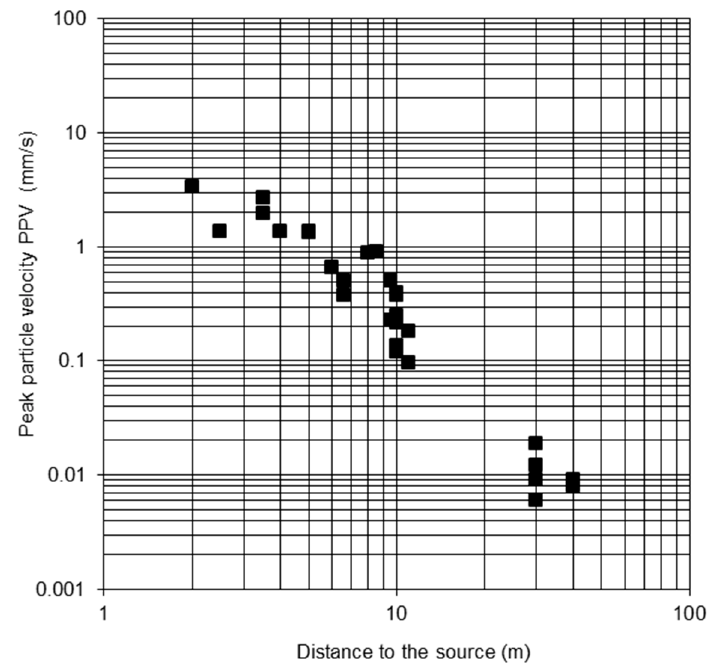
Figure 4. Logarithmic graph of the excavation, ripping and fragmentation equipment (without vibration).